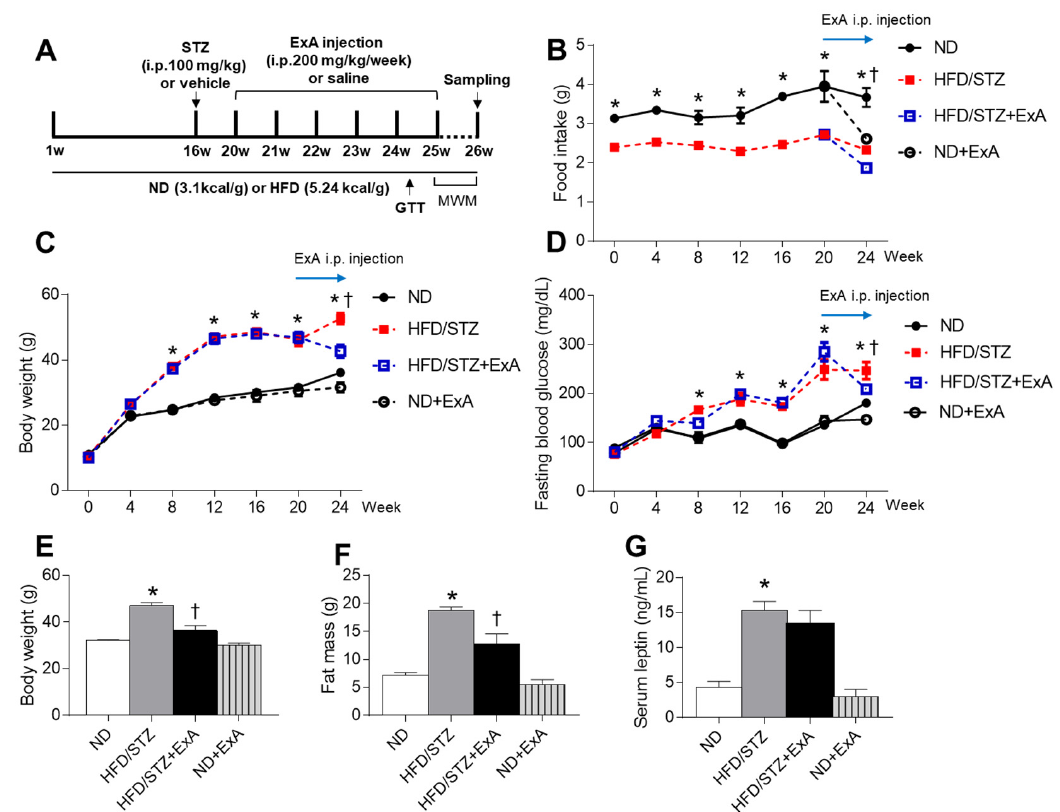
Figure 2. Effects of long-acting exendin-4-ABD-anti-FcRn affibody (ExA) on food intake and body weight in HFD/STZ mice. ( A ) Schematic drawing of experimental schedule. Glucose tolerance test (GTT) and Morris Water Maze (MWM) test were performed before mice sacrificed. ( B ) Food intake, ( C ) body weight, and ( D ) fasting blood glucose levels in ND-fed and HFD/STZ mice with or without ExA treatment over time. ( E ) Body weight, ( F ) fat mass, and ( G ) serum leptin levels 6 weeks after ExA treatment. Data are shown as the mean ± SEM. *: p < 0.05 vs. ND-fed mice, †: p < 0.05 vs. HFD/STZ mice.